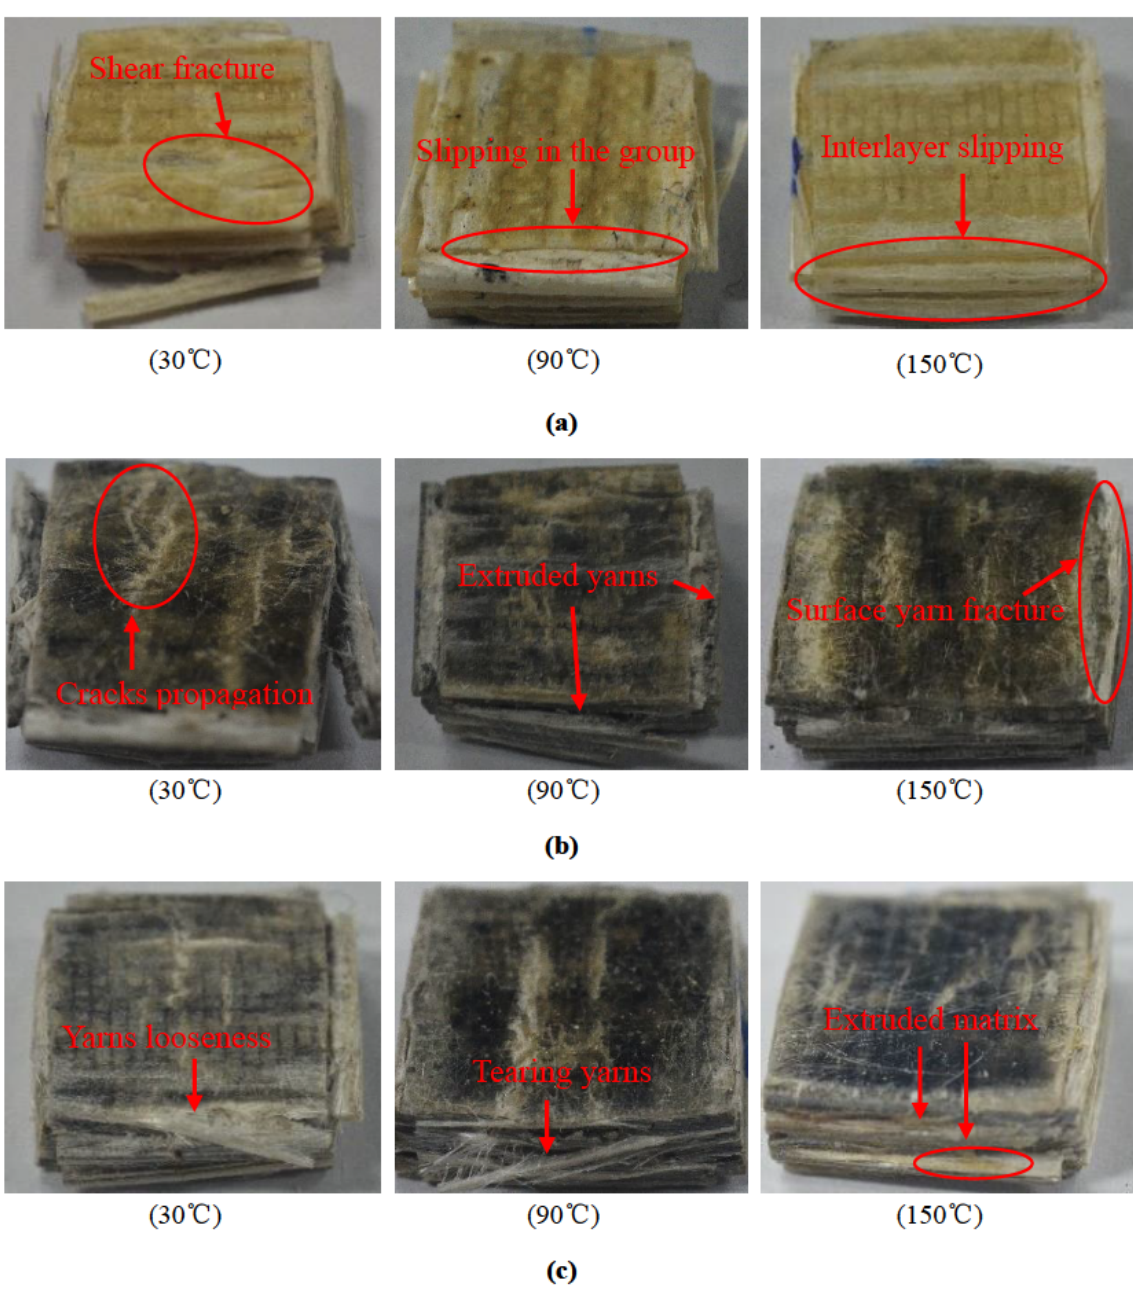
Figure 10: Out-of-plane compression fracture morphologies at different temperatures: (a) desized composite; (b) D 400 -GO-grafted compos- ite; (c) GO-grafted